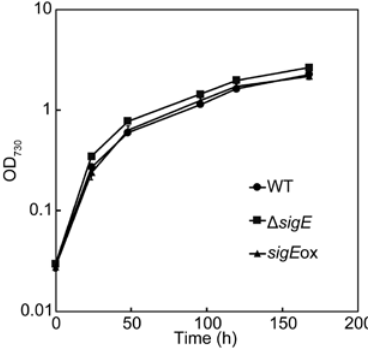
Figure 1. Cell growth curve of wild-type (WT), sigE deleted ( ∆ sigE ) and overexpressed ( sigE ox) strains of Synechocystis sp. PCC 6803. Flask-scale cultivations were performed in modified BG11 medium containing 5 mM NH 4 Cl as a nitrogen source under photoautotrophic conditions with continuous light at 40 µmol m − 2 s − 1 . Means of triplicate cultivations were represented with standard deviations.